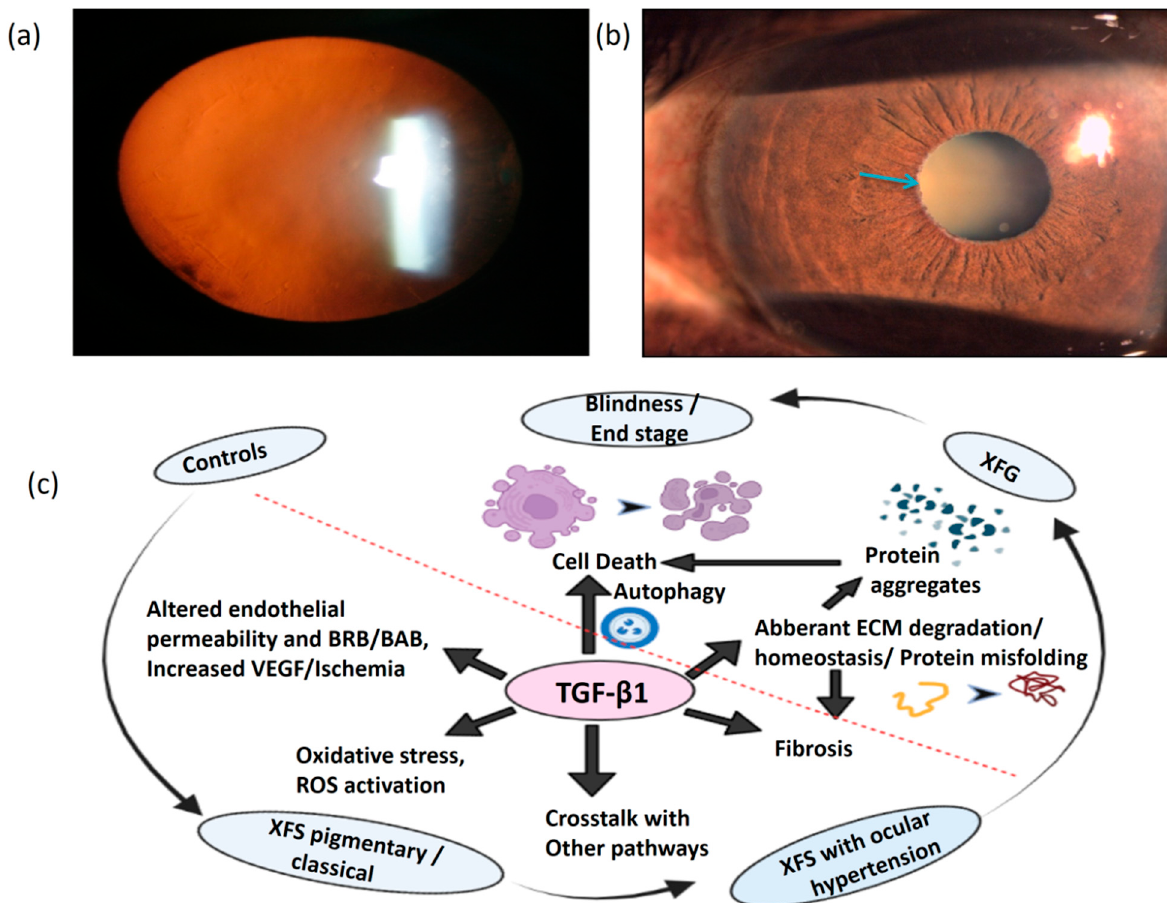
Figure 1. ( a ) Retroillumination showing peripheral granular exfoliative deposits, ( b ) exfoliative deposits (indicated by blue arrow) over the pupil with diffuse stromal iris atrophy, ( c ) diagrammatic depiction of the role of TGF- β 1 in various cell processes and the changes that occur as the disease progresses from normal (control) to exfoliation syndrome (XFS) to exfoliation glaucoma (XFG).TGF-